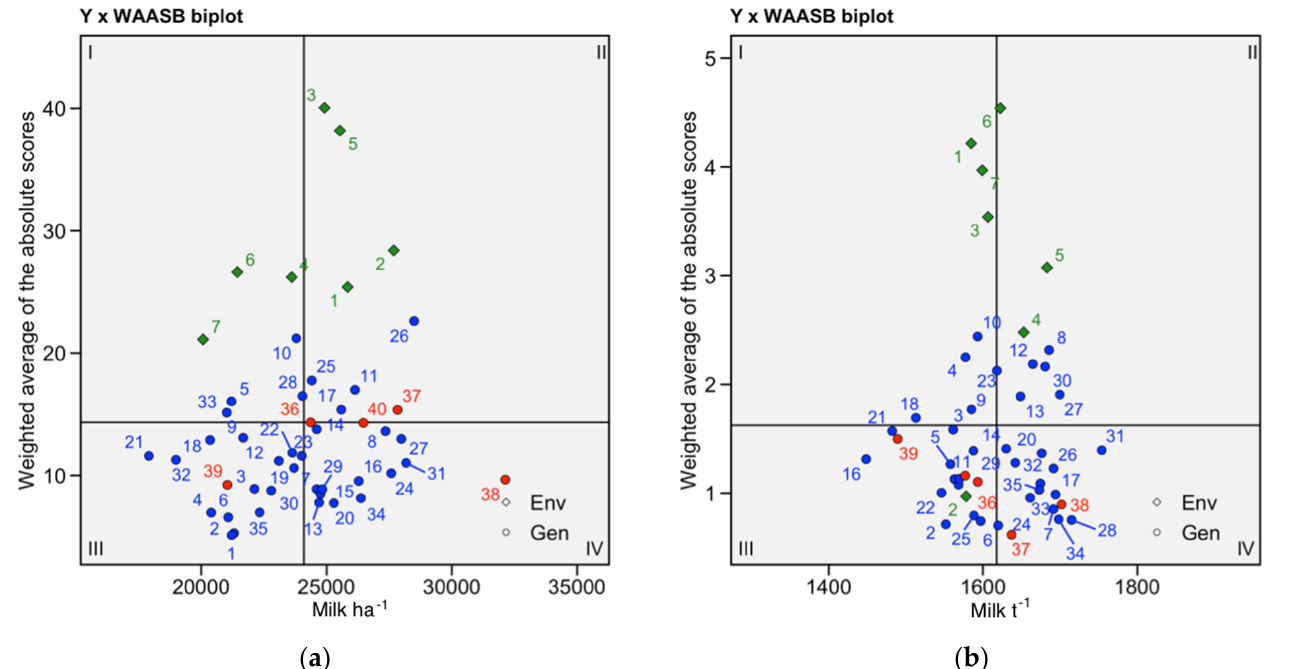
Figure 4. ( a ) Milk ha − 1 WAASBxY plot.; ( b ) Milk t − 1 WAASBxY plot; highlighted in red are industry standards. Environments are represented by greed rhomboids.